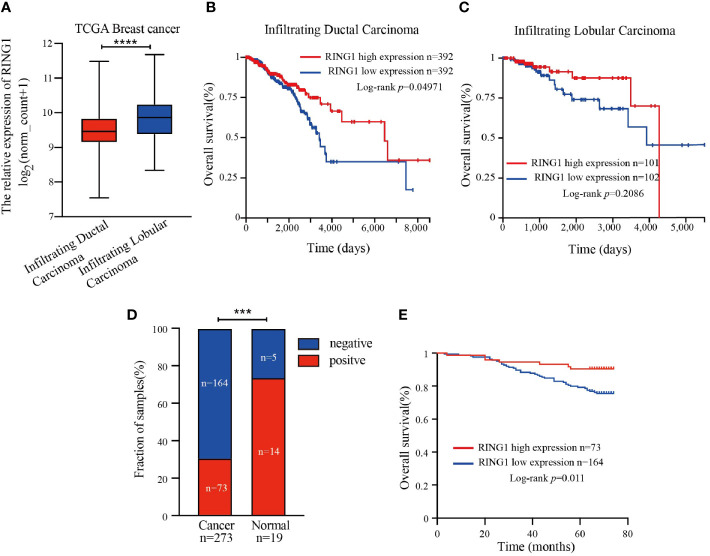
RING1 was downregulated in breast cancer and predicted poor outcome. (A) Analysis of RING1 mRNA expression level in IDC and ILC according to the TCGA data. Kaplan–Meier survival analysis for patients with IDC (B) or ILC (C) by log-rank test and according to the TCGA data. (A–C) results were calculated by the XENA web tool. (D) Quantification of positive and negative RING1 expression in breast cancer and normal tissues by χ2 test. (E) High expression of RING1 is correlated with better overall survival. IDC, Infiltrating Ductal Carcinoma; ILC, Infiltrating Ductal Carcinoma; ***p < 0.001, ****p < 0.0001.